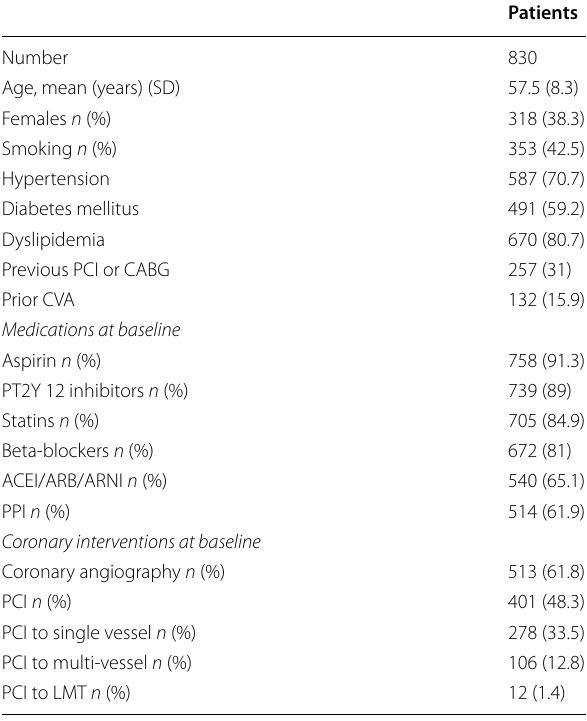
Table 1 Baseline characteristics of all included